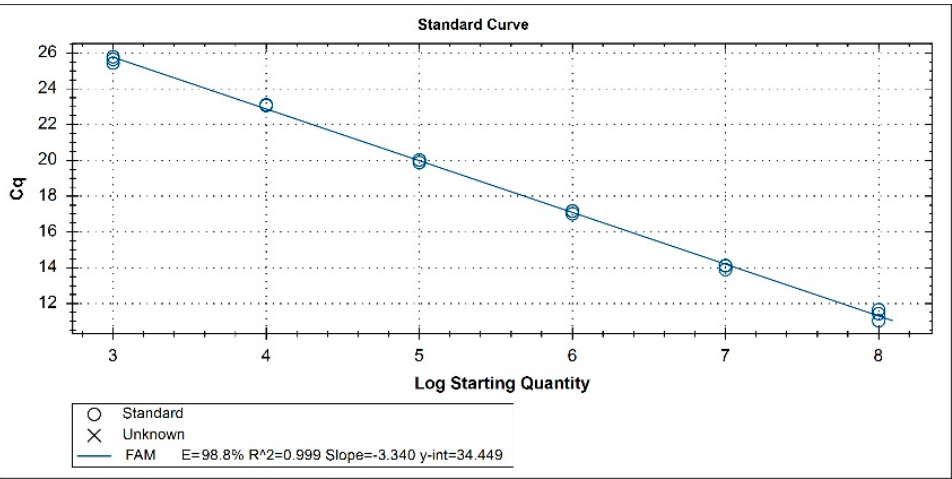
Figure 1. Standard curve of NADC34-like PRRSV real-time RT-PCR for serially diluted. The standard curve represents three replicates of each plasmid concentration (between 7.80 × 10 8 copies/µL and 7.80 × 10 3 copies/µL). Ct values from three replicates ( y -axis) are plo tt ed versus logarithmic concentrations of plasmid copies ( x -axis).